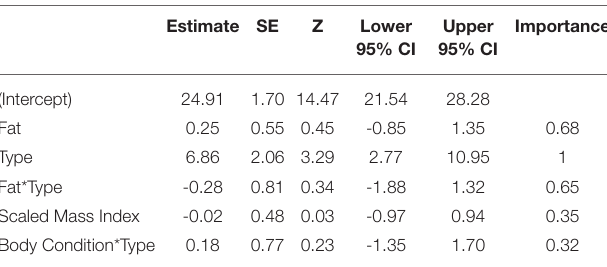
TABLE 2B | Conditional model average of the top three models within 2AICc for body condition